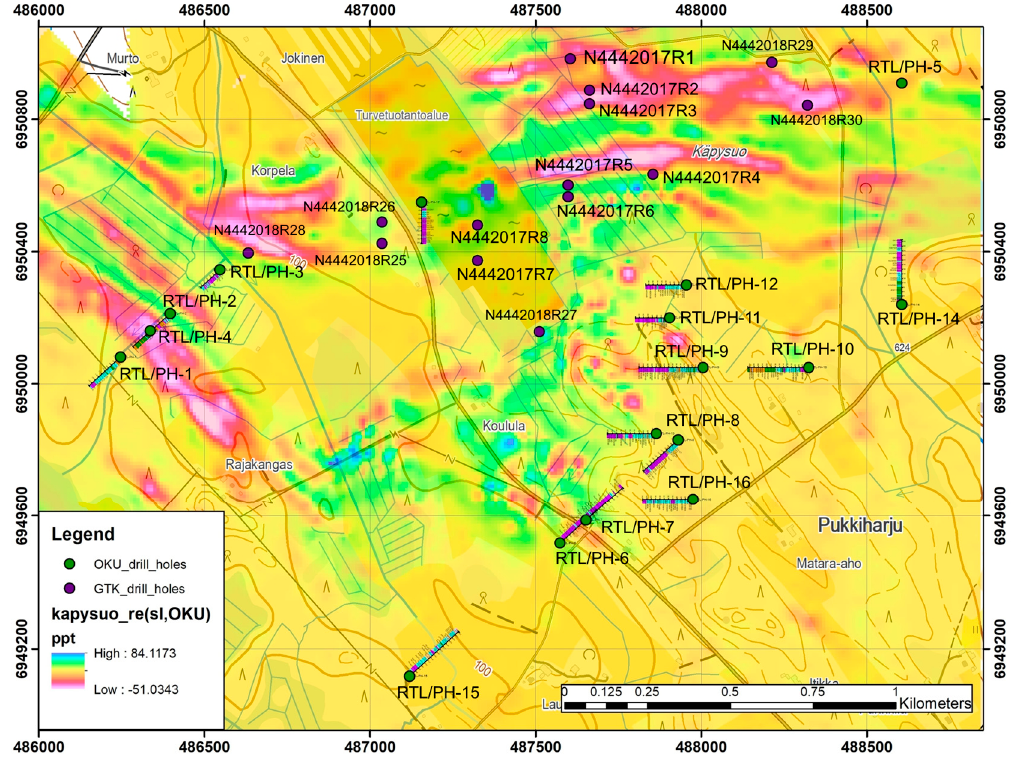
Figure 1. Magnetic map of the studied area. Finland–DigiKP 2018 and EM GEM-2 profiles (in-phase 1475 Hz), boreholes, and electrical resistivity tomography (ERT) profiles. Background: electromagnetic slingram in-phase component, LiDAR data (© National Land Survey of Finland).